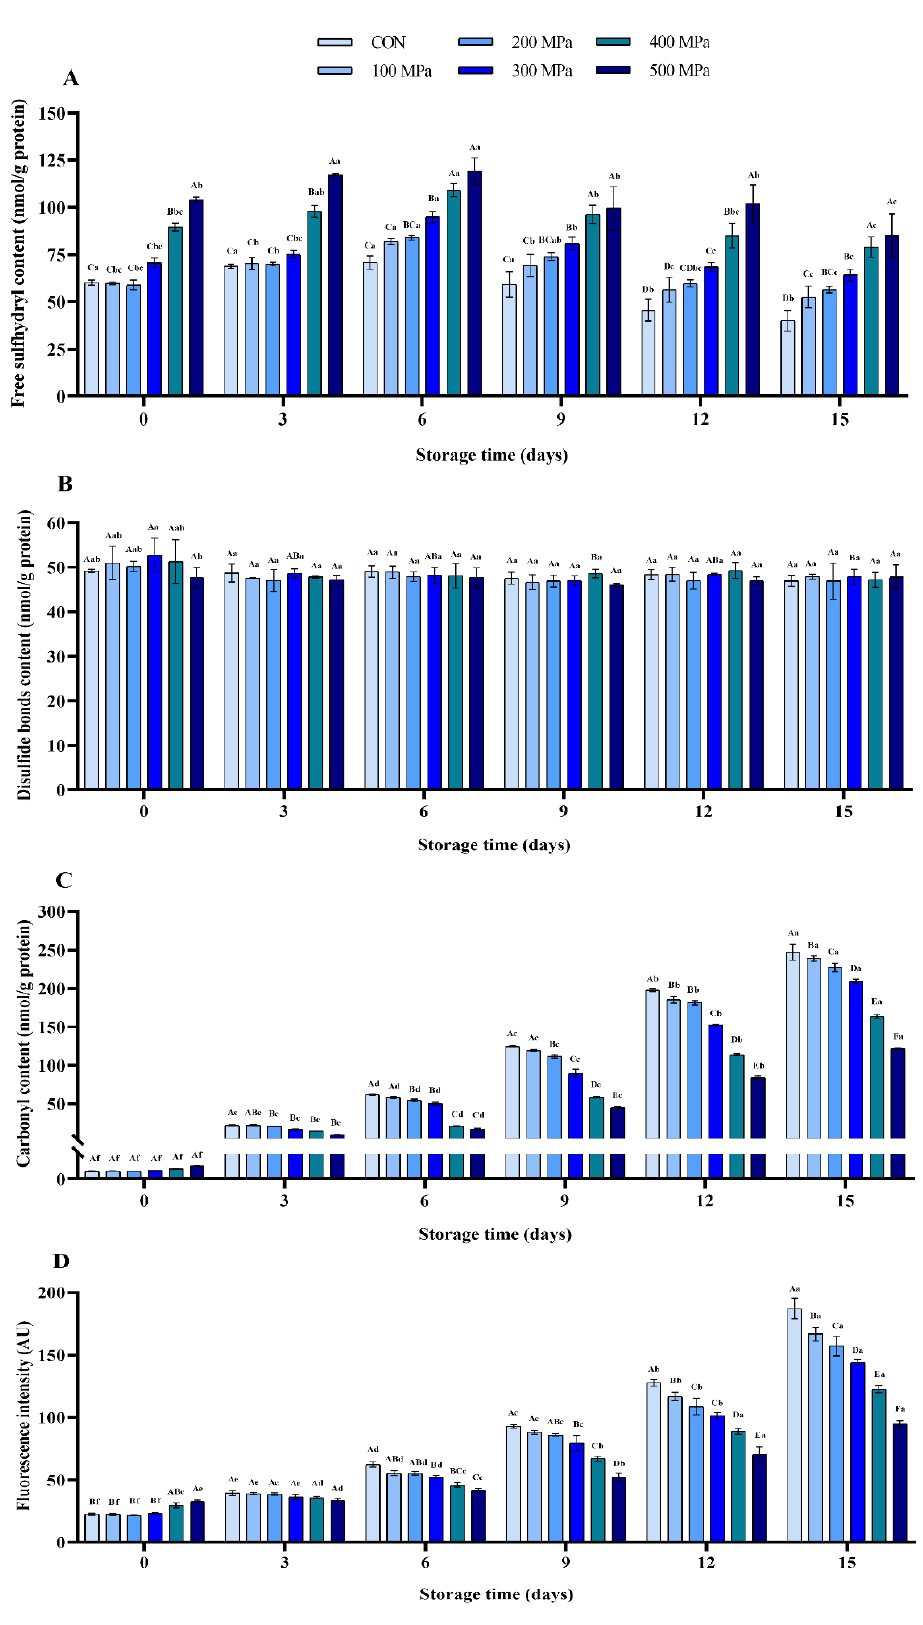
Figure 2. Effects of UHP treatment on protein oxidation of shrimp during storage: the content of